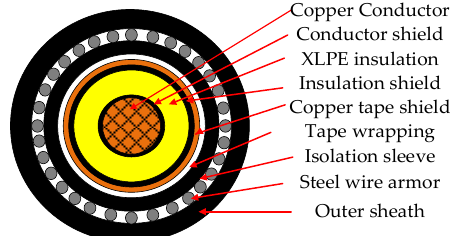
Figure 5. Single-core cable structure.